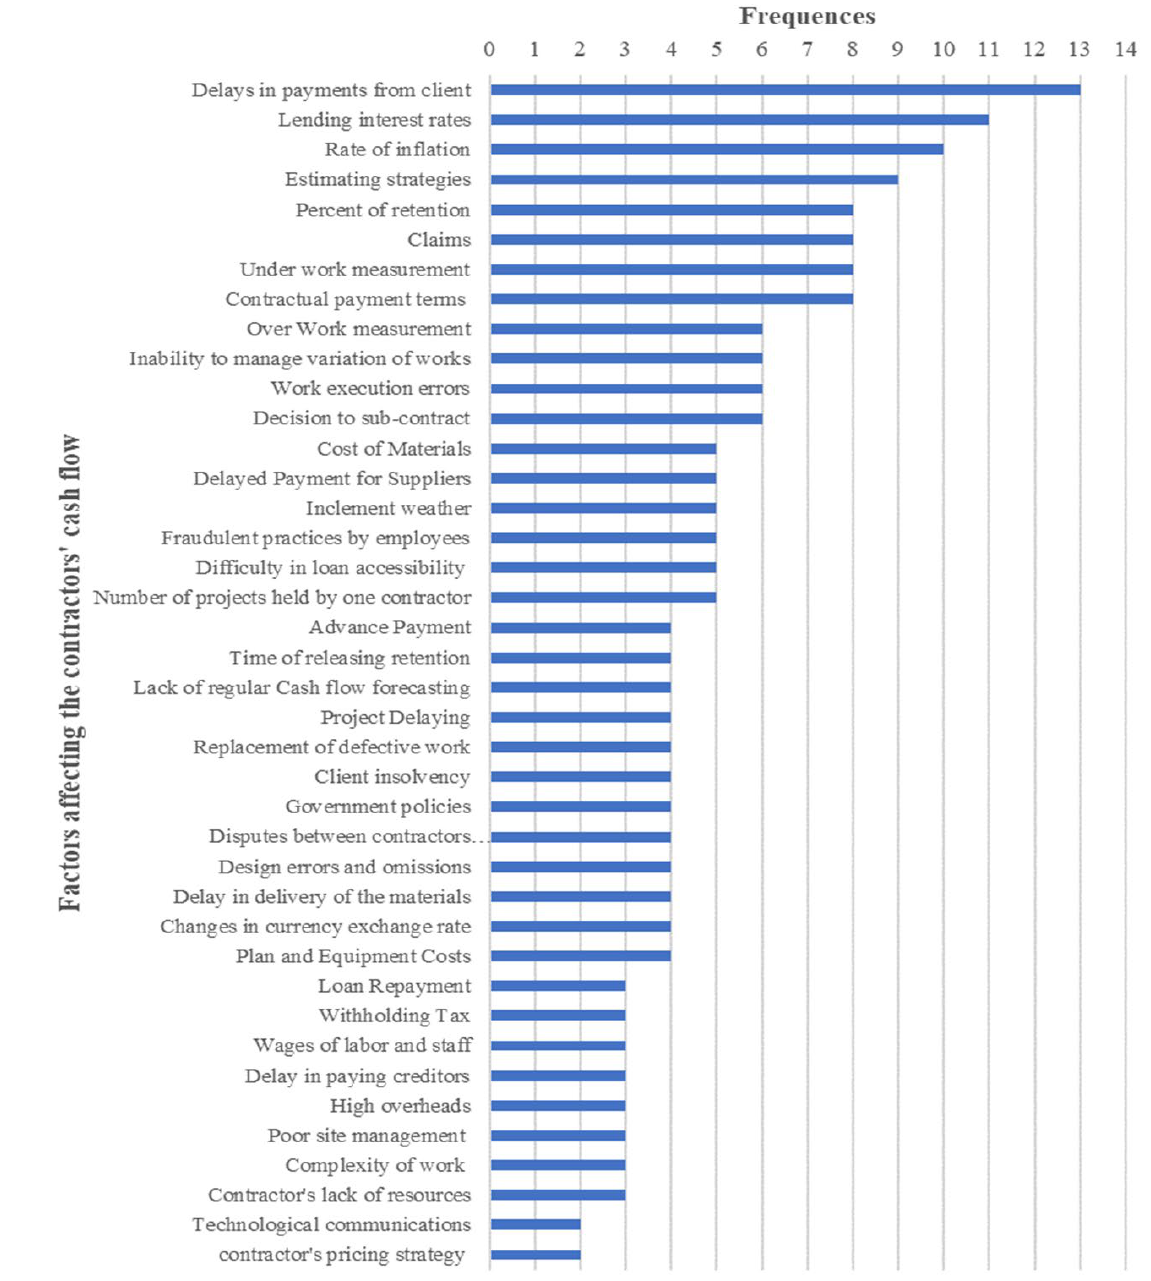
Figure 7. Factors affecting the contractors’ cash flow .